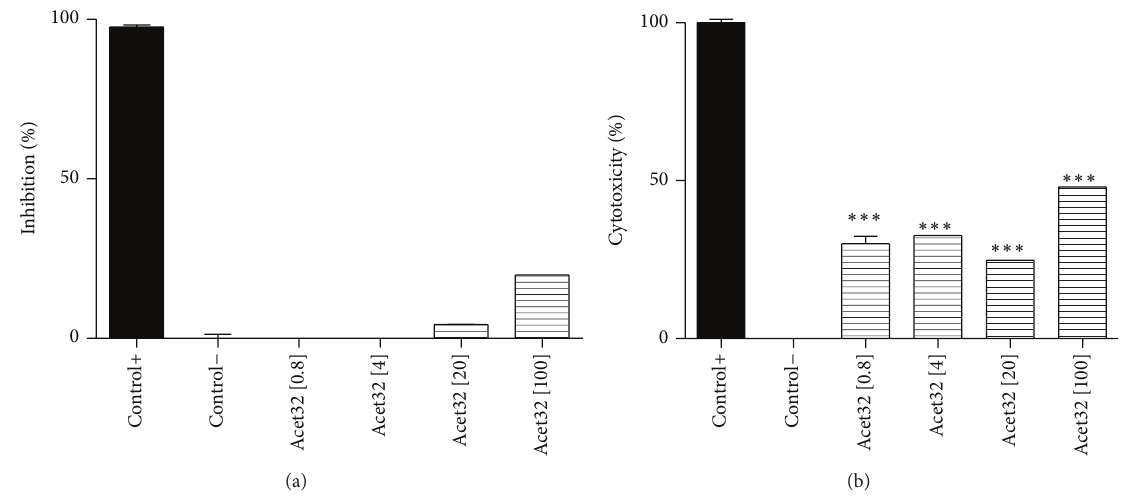
Figure 6: (a) Inhibitory effect of Mycobacterium bovis BCG growth by Acet32 (afzelin) tested at four different concentrations, 0.8; 4; 20; and 100 𝜇 g/mL. The percentage of inhibition was compared with the positive control (rifampicin), 98.17 ± 0.8 % / O . D.: 0.180 ± 0.8 , and negative control (medium + mycobacteria), 0.1 ± 0.1 % / O . D.: 0.880 ± 1.24 . (b) Cytotoxicity of Acet32 (afzelin) tested at four different concentrations 0.8; 4; 20; and 100 𝜇 g/mL against murine macrophages RAW 264. The percentages were compared to positive control, macrophages treated with Triton 1%: 98.88 ± 1.6/ O . D.: 0.132, and negative control, macrophages without treatment: 0.01 ± 0.1/ O . D.: 0.749. ∗ 𝑃 < 0.05 , ∗∗ 𝑃 < 0.01 , and ∗∗∗ 𝑃 < 0.001 , significance obtained by ANOVA and posttest Tukey ( 𝑛 = 3 ), when compared to the negative control (a) and positive control